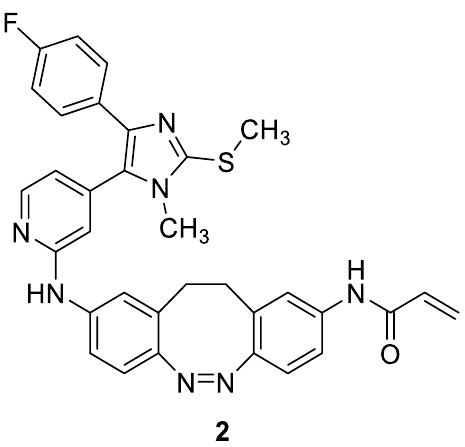
Figure 3. Structure of photoswitchable covalent JNK3 inhibitor 2 .